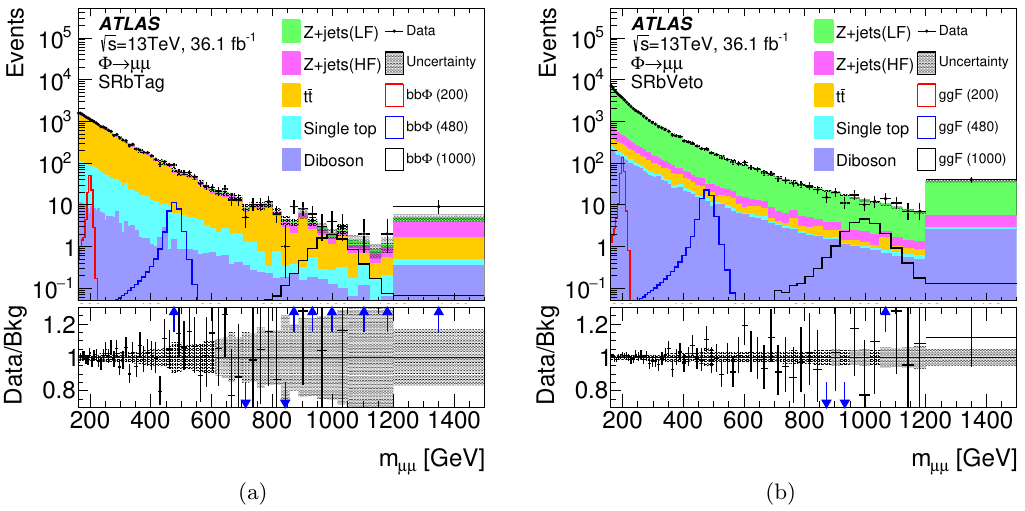
Figure 2 . Distributions of the dimuon invariant mass, m (cid:22)(cid:22) , after the combined (cid:12)t to data are shown normalized: (a) in the SRbTag, under the background plus signal hypothesis (480 GeV bb (cid:8) signal) and (b) in the SRbVeto, under the background plus signal hypothesis (480 GeV ggF signal). The (cid:12)t for a m (cid:8) =480 GeV signal corresponds to the largest excess observed above the background expectation. Each background process is normalized according to its post-(cid:12)t cross-section. The templates for the m (cid:8) =200 GeV, m (cid:8) =480 GeV and m (cid:8) =1 TeV mass hypotheses are normalized to the expected upper limit. The data are shown by the points, while the size of the statistical uncertainty is shown by the error bars. The last bin includes the over(cid:13)ow. The blue arrows represent the data points outside of the frame. The hatched band shows the total systematic uncertainty of the post-(cid:12)t